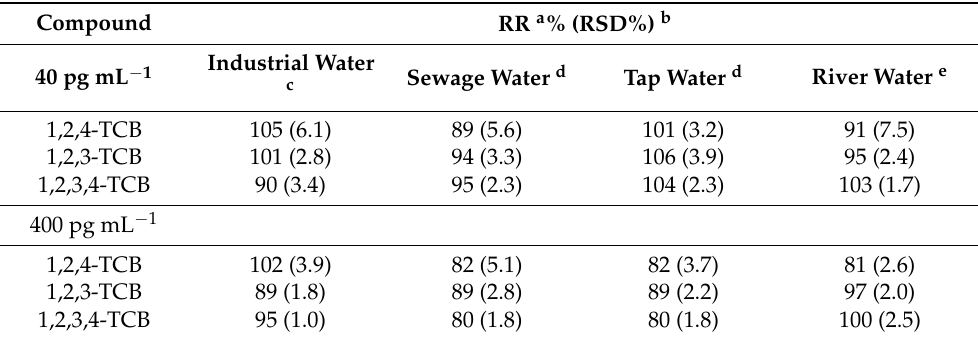
Table 2. Results of HS-SPME analysis of CB mixtures using the PU–PSU/Calix[4]arene in different real water samples.